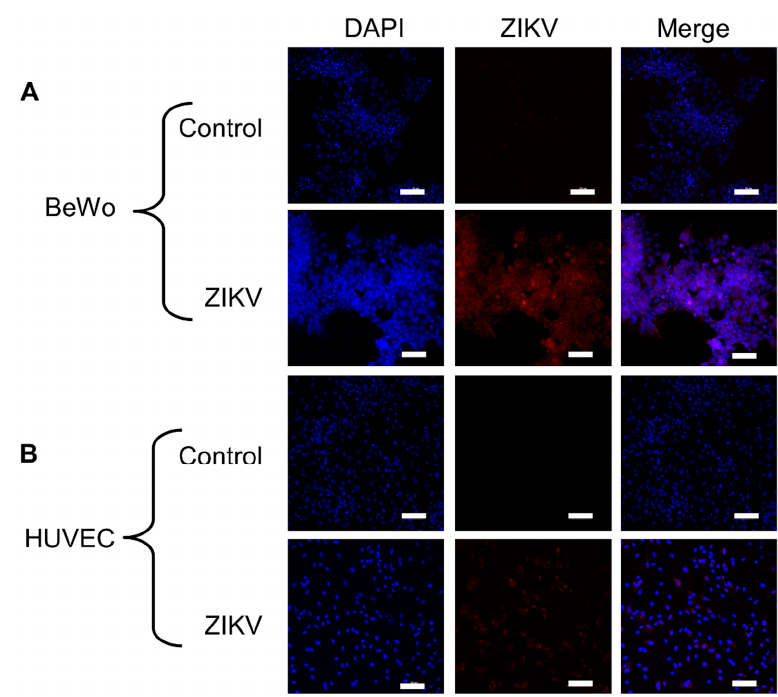
Figure 3. Monolayer infection of BeWo and HUVEC cells with ZIKV viewed under 20 × magnification. ( A ) BeWo monolayer stained 48 h p.i. with ZIKV. ( B ) HUVEC monolayer stained 48 h p.i. (blue = DAPI, red = ZIKV–4G2). Scale bar represents 100 µM.